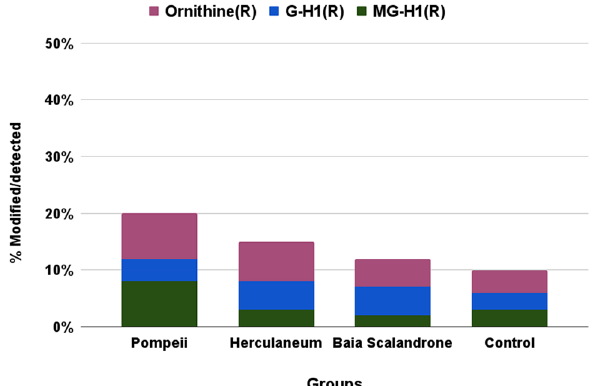
Figure 5. Extent of modified arginine residues, reported as percentage of modified over detected (modified plus unmodified) ones.